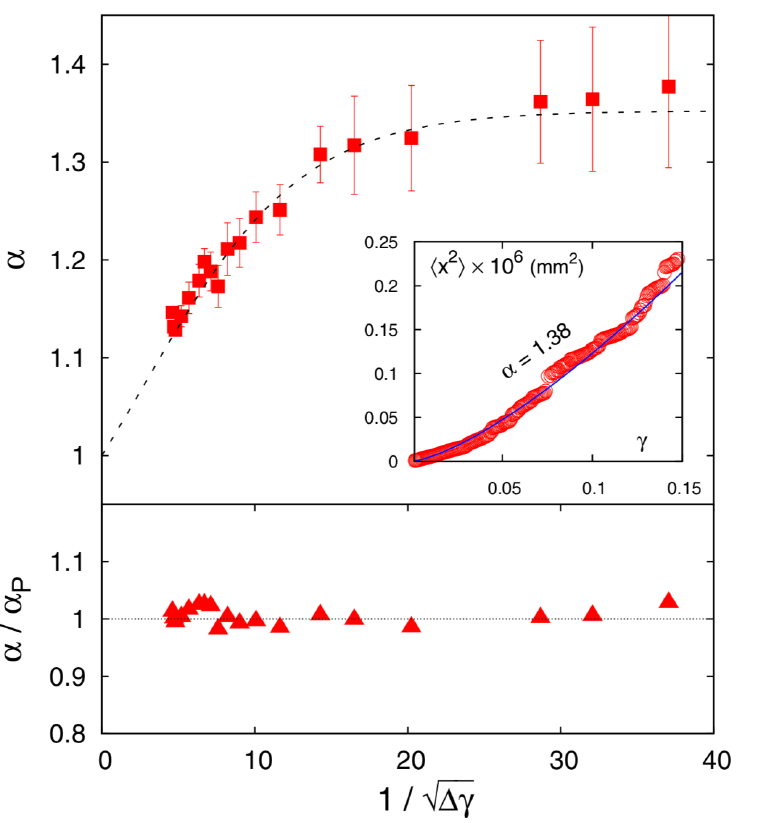
Figure 18. Verification of the scaling law α = 2/ ( 3 − q ) [108] for several regimes of diffusion. Top : √ ∆ γ ; the dashed line is a direct Evolution of the measured diffusion exponent α as a function of 1/ √ ∆ γ ) = 2/ [ 3 − application of the scaling law from the fit of the values shown in Figure 17, α ( 1/ √ ∆ γ )] . Inset : A typical diffusion curve showing the mean square displacement fluctuations (cid:104) x 2 (cid:105) q ( 1/ as a function of the shear strain γ ; this allows the assessment of the diffusion exponent α ≡ µ for each strain window tested. In the case shown, it corresponds to the smallest strain window, the rightmost point in the curve in the main panel. Note that for a constant strain rate, γ is proportional to time. Bottom : Measure of the deviation of the data relative to the scaling law prediction α P = 2/ ( 3 − q ) , √ ∆ γ , showing a remarkable agreement of the order of ± 2%. From as a function of 1/